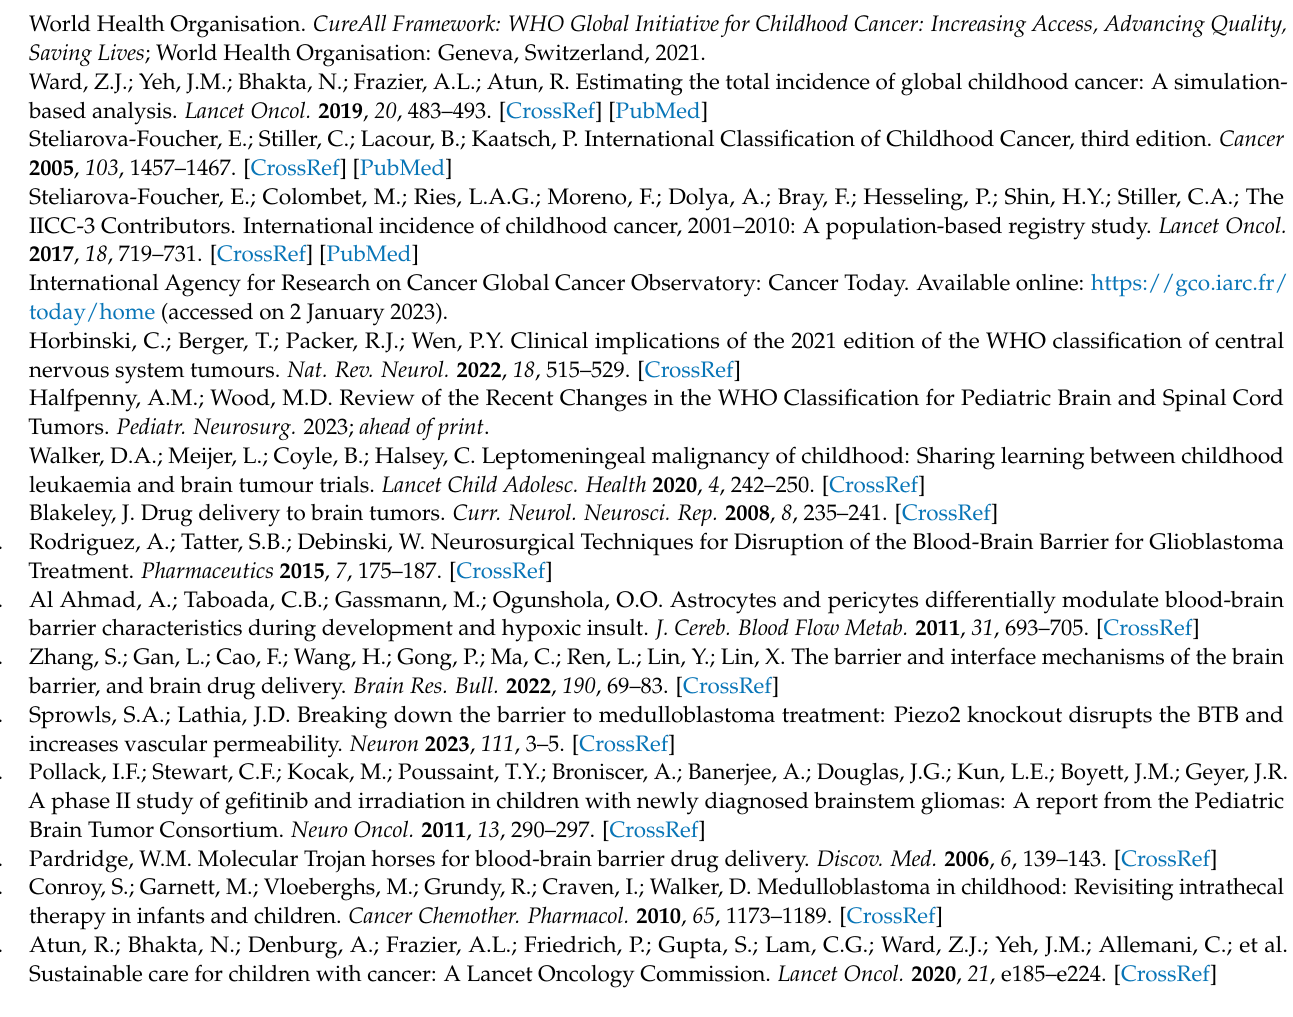
Table S3: Published clinical trials and clinical reports of CED in high-grade glioma; Table S4: Drug mechanism references and databases; Table S5: Approved drugs used in pediatric drug screening; Table S6: Drugs graded by eligibility for trial by intrathecal administration for